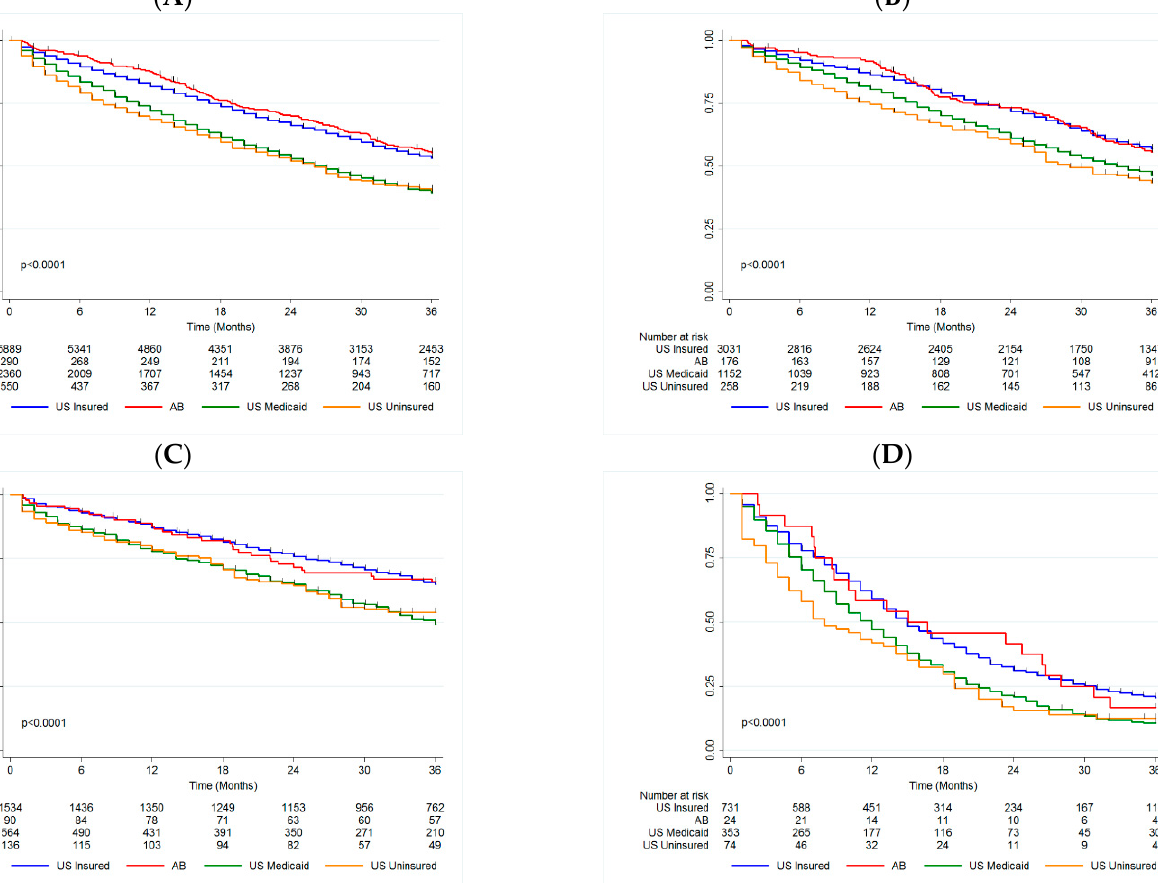
Figure 1. Kaplan-Meier with log-rank by Insurance Status in ( A ) Overall Cohort, ( B ) HR+/HER2 − patients, ( C ) HER2+ patients, and ( D ) TN patients. AB Alberta, HR+ hormone receptor positive, HER2 − human epidermal growth factor receptor-2 negative, HER2+ human epidermal growth factor receptor-2 positive, TN triple negative, US United States.